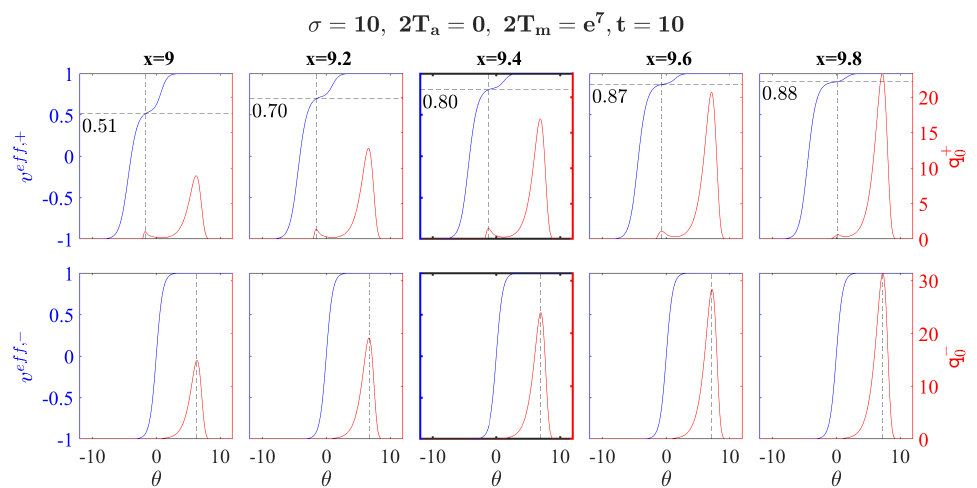
Figure 4: Effective velocities (left axis, blue) and spectral density cross-sections (right axis, red) of particle ( ` ) in row 1 and ( ´ ) in row 2 at time t “ 10 in the case of no bath. For particle ` we see the subsidiary (decaying) and free fermion peaks whereas for particle ( ´ ) we see the interacting peak. Columns show these quantities sequentially for positions x “ 9,9.2,9.4,9.6,9.8. The central emphasised column corresponds to x “ x ˚ “ 9.4, that is the position of the maximum of the subsidiary peak of particle ( ` ). The vertical dashed lines indicate the maximum of particle ( ` ) subsidiary peak ( θ ˚ “ ´ 1.26) in row 1 and the maximum of particle ( ´ ) interacting peak in row 2, which is around the value θ ˚ ` σ as dictated by the structure of the scattering phases. The horizontal dashed lines indicate the effective velocity of the maximum of particle ( ` ) subsidiary peak and are annotated with the corresponding numerical